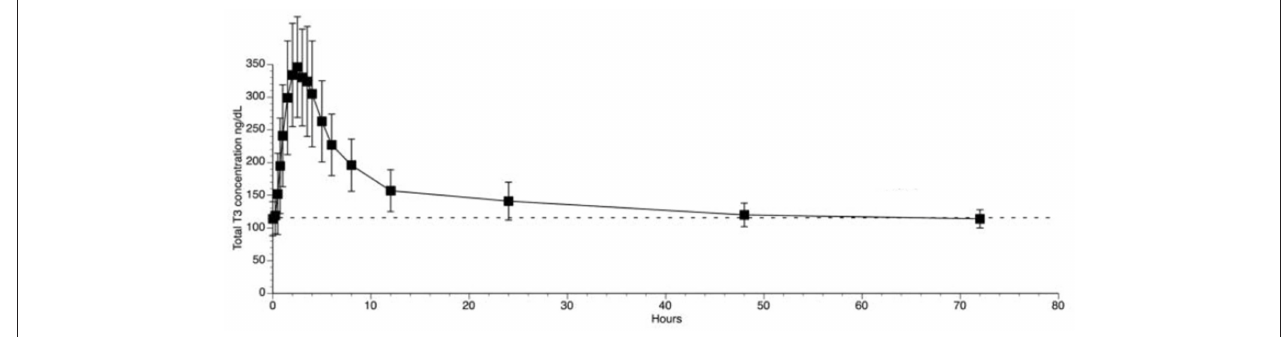
FIGURE 1 | T3 serum concentrations for 3 days following oral administration of a single 50 mcg dose of liothyronine to volunteers. Adapted from Jonklaas et al.